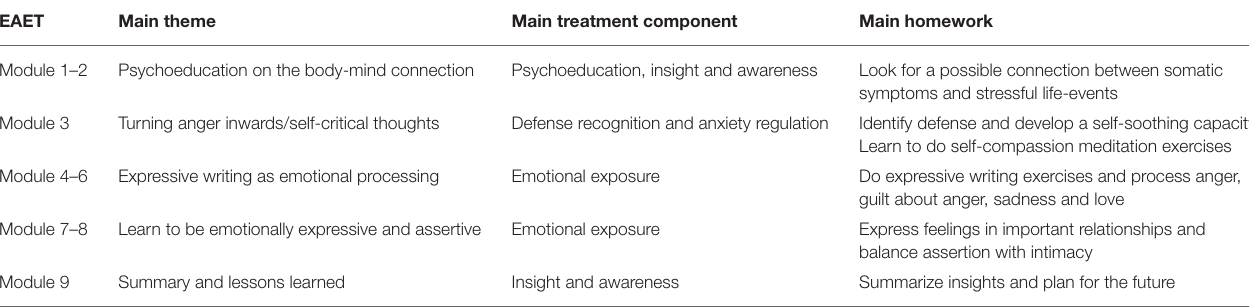
TABLE 1 | Structure and content of internet-based emotional awareness and expression